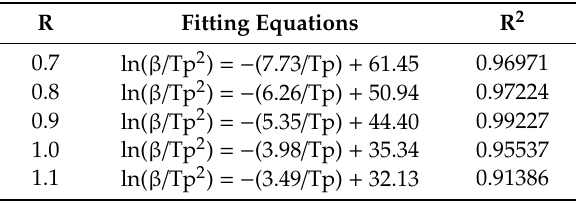
Table 5. The fitting equations and R 2 .